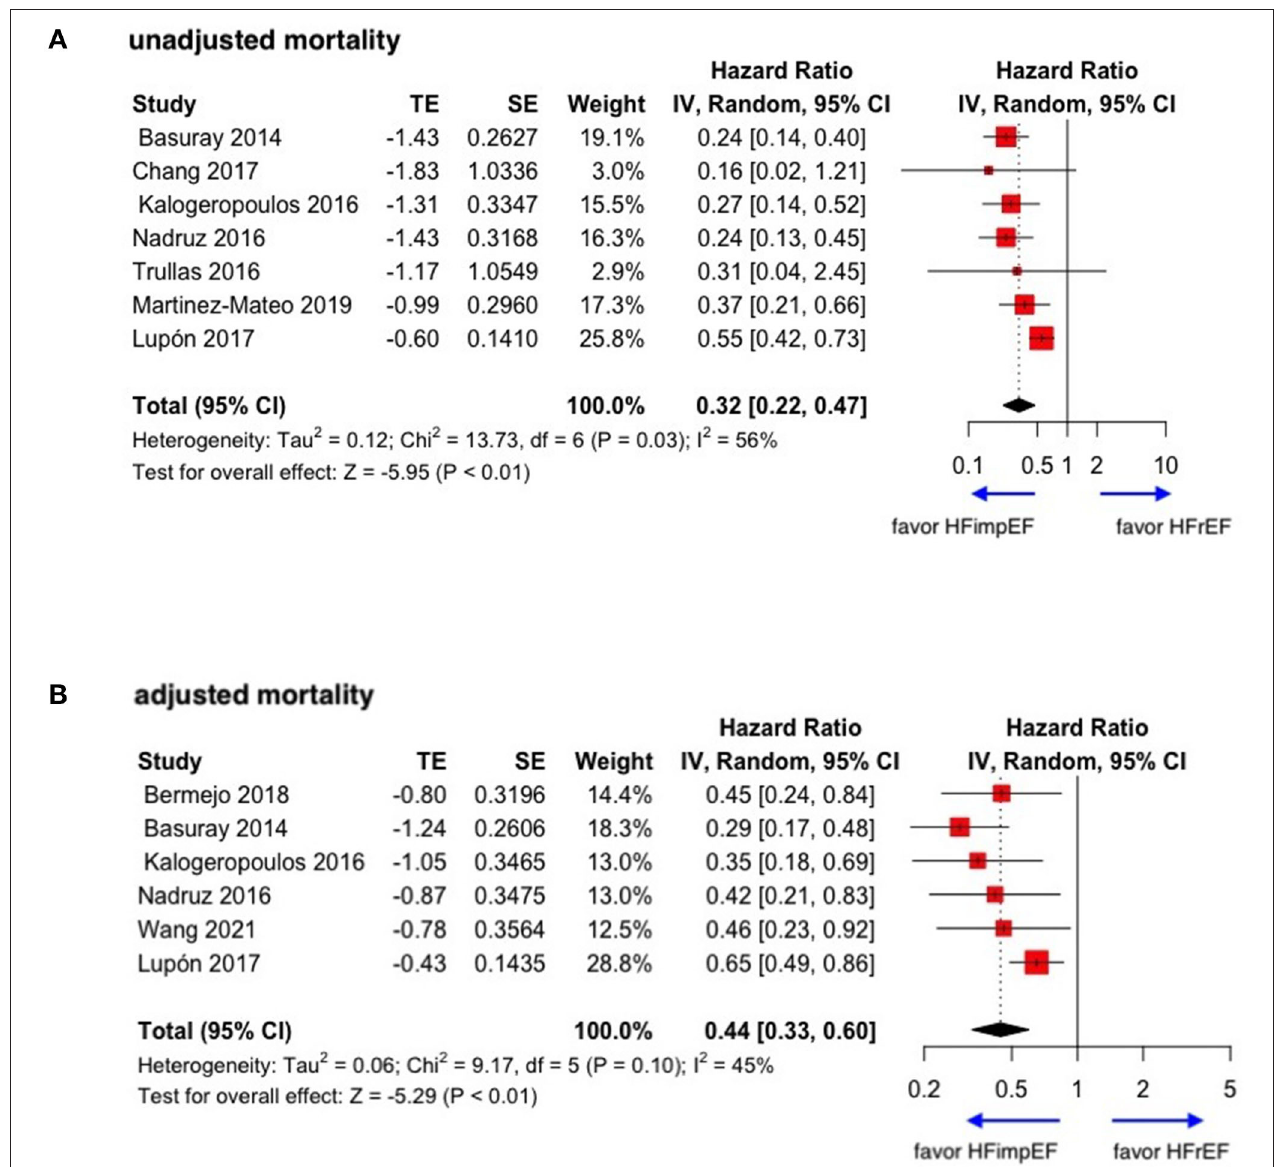
FIGURE 2 | Forest plots of unadjusted and adjusted mortality in patients between HFimpEF and HFrEF. (A) Unadjusted mortality. (B) Adjusted